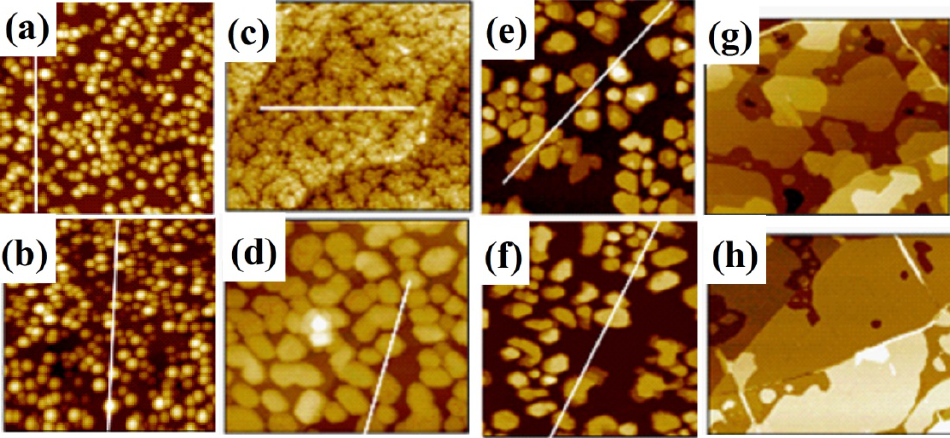
Figure 18. The morphologies and thermal stability of high coverage Fe, Gd, and Eu on graphene. ( a ) 250 × 250 nm 2 area after Fe deposition on graphene at RT with θ = 3 ML, F = 0.25 ML/min. The island density is N = 5.1 × 10 − 3 islands/nm 2 ; ( b ) Annealing at 600 K for 20 min from ( a ) does not change island density significantly, only the shape of individual islands equilibrates and their average height increases; ( c ) Fractal-like morphology of 4 ML Gd on graphene grown at RT in 250 × 215 nm 2 area, F = 0.1 ML/min. Fractal morphology is stable up to 800 K, but transition to crystalline shapes occurs at higher temperature, as shown in ( d ) where previous film was annealed at 1050 K for 5 min; ( e ) 2.0 ML of Dy deposited on graphene at RT, image area 100 × 100 nm 2 , F = 0.22 ML/min, island density N = 6 × 10 − 3 islands/nm 2 ; (f) annealing of ( e ) to 580 K transforms multiple level islands with 4–7 Dy layers exposed into more uniform height shaped islands and some of them coalesce, indicating lower thermal stability of Dy nanoparticles on graphene, as compared with Fe and Gd; ( g ) 2.6 ML of Eu deposited on graphene at RT, image area 250 × 200 nm 2 , F = 0.16 ML/min; ( h ) Annealing of the Eu film from ( g ) at 365 K for 15 min transforms the lager islands into almost continuous film with thickness of 3 ML.